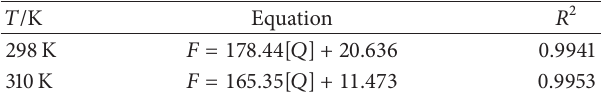
spectrum of warfarin (HSA or warfarin-ferulic acid) was recorded in the range from 280 to 450 nm using UV-2450.